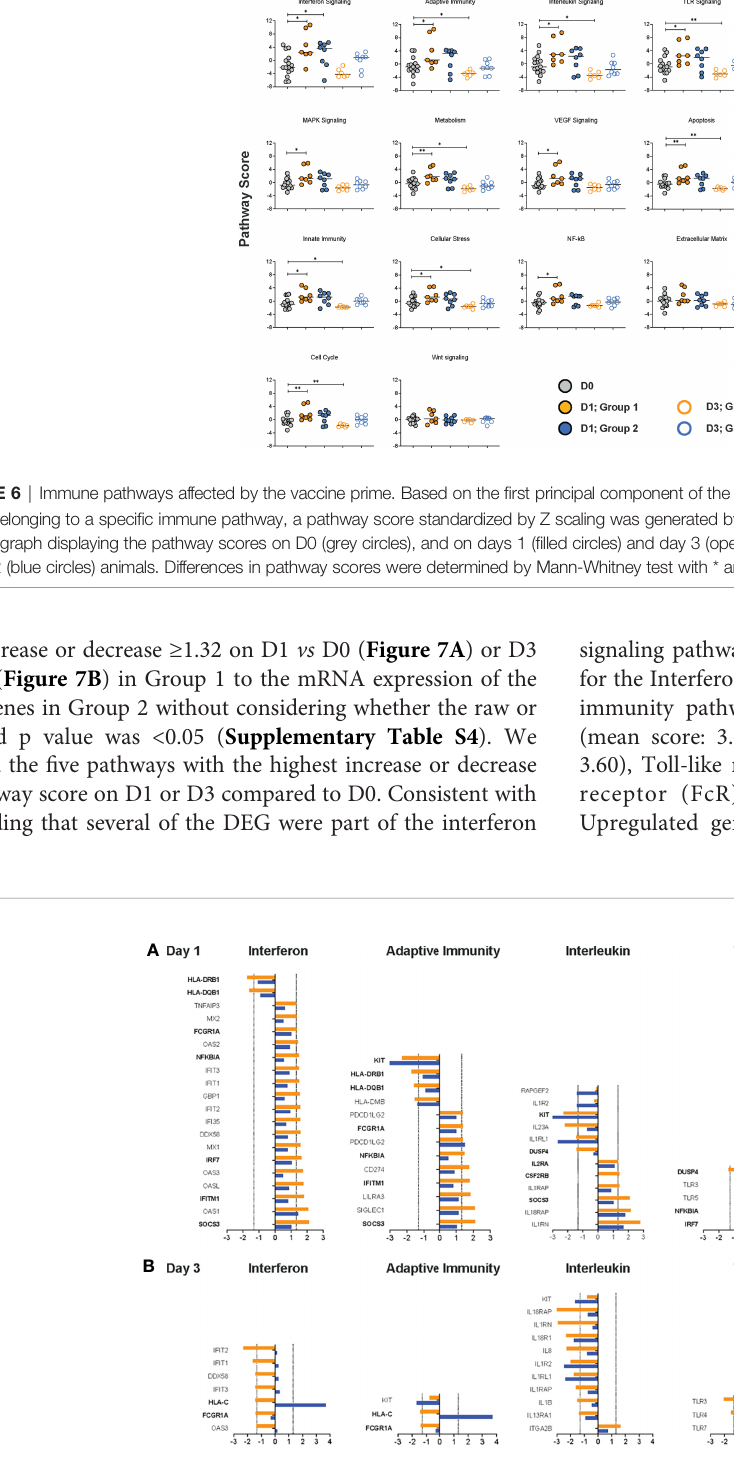
FIGURE 7 | Changes in gene expression between Group 1 and Group 2 animals for the top pathways impacted by the vaccine prime. For each of the top 5 pathways, the mean log 2 increase in mRNA levels on D1 compared to D0 (A) or D3 compared to D0 (B) is shown for genes within the pathway that had a log 2 increase ≥ 1.3.2 or decrease (dashed lines) in Group 1 (orange bars). The mean change in mRNA levels of the same genes in animals of Group 2 is indicated by blue bars. Genes for each pathway are listed on the y-axis. Bolded genes indicate genes that are present in more than one pathway. 0.